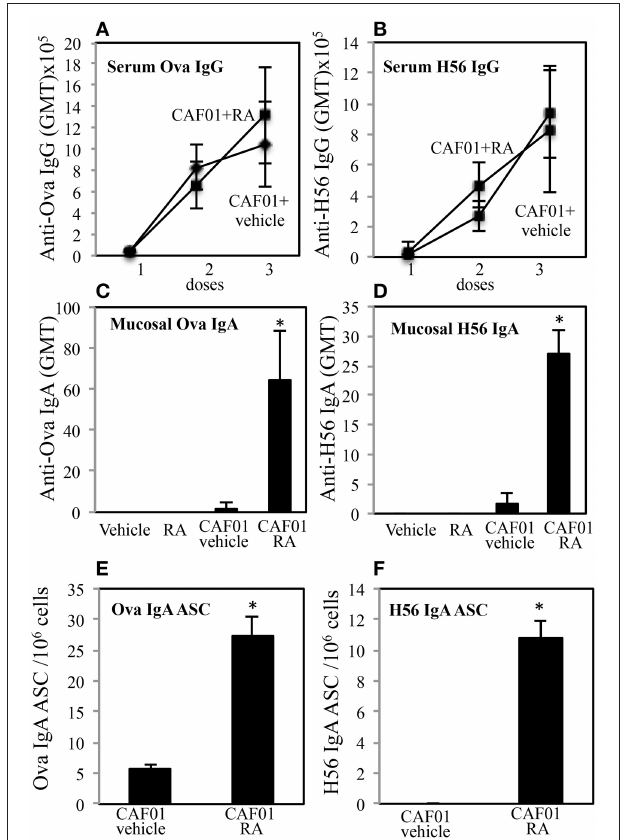
FIGURE 1 | Parenteral immunization in presence of RA promotes mucosal Ag-specific immune response in CB6F1 mice. Serum IgG (A,B) and vaginal IgA (C,D) responses to OVA (5 µ g/dose) (A,C) and to H56 (0.5 µ g/dose) (B,D) in CB6F1 mice (5/group) treated or untreated with RA (300 µ g/dose, 200 µ g/dose and 100 µ g/dose) or its vehicle (sesame oil) and immunized with CAF01 (125 µ g/dose) and OVA protein (5 µ g/mouse) or H56 (0.5 µ g/dose). Results are expressed as IgG or IgA geometric mean titer (GMT). The IgG titer was determined in sera and IgA in vaginal washes. Ag-specific long living plasma cells in the bone marrow of CB6F1 mice treated or untreated with RA or its vehicle (sesame oil) and immunized with CAF01 (125 µ g/dose) and OVA (5 µ g/dose) (E) or H56 (0.5 µ g/dose) (F) . Ag-specific IgA antibody secreting cells (ASC) were analyzed by ELISPOT assay. Bars indicate SEM of 4 mice /group. Asterisks indicate significant differences between groups at the analyzed time point; * p -value < 0.05. One rapresentative experiment is shown of three